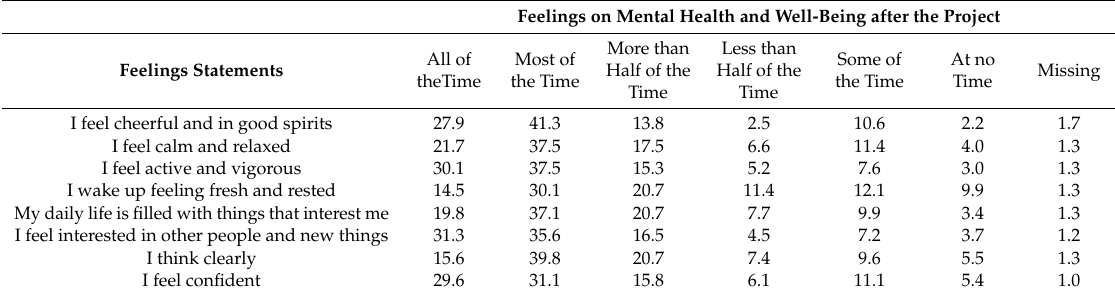
Table 4. Mental health and well-being after the project.